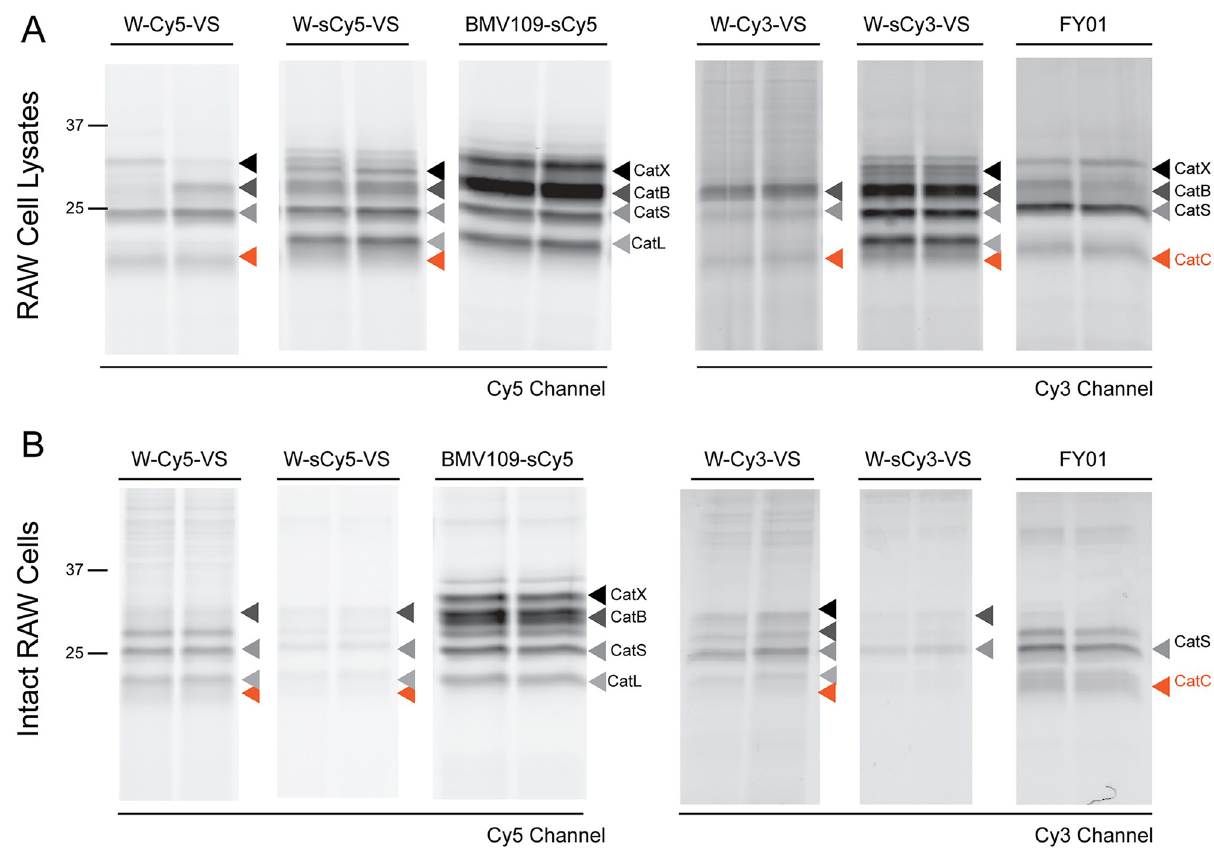
Fig 5. Labelling of cysteine cathepsins in mammalian cells. ( A ) Lysates from RAW macrophages were treated with 1 μ M of the indicated ABPs for 30 min. ( B ) Live RAW cells were treated with 1 μ M of the indicated ABPs for 3 h. Samples were run on a SDS-PAGE gel, and in-gel fluorescence measured using a fluorescence scanner. The identity of the different cysteine cathepsins are indicated with different coloured arrowheads.